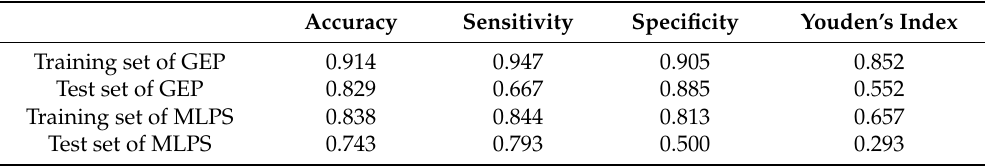
Table 4. Results of GEP and MLPs.